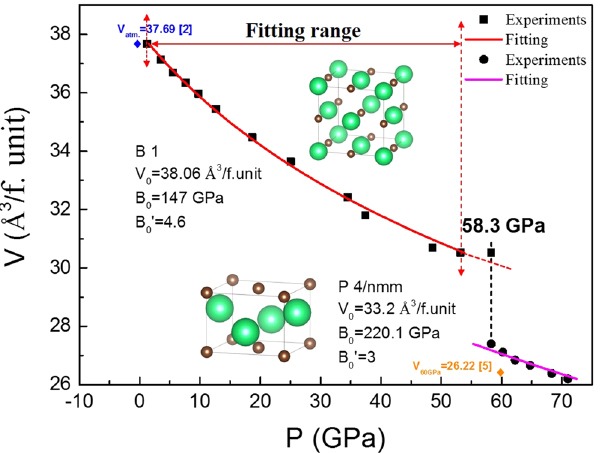
Figure 3. The pressure-volume data of ThC-B1 and P4/nmm phases up to 71.0 GPa. The solid lines represent the fitted result using 3rd order Birch-Murnaghan equation of state. The two diamond symbols represent the values from two previous reports respectively for